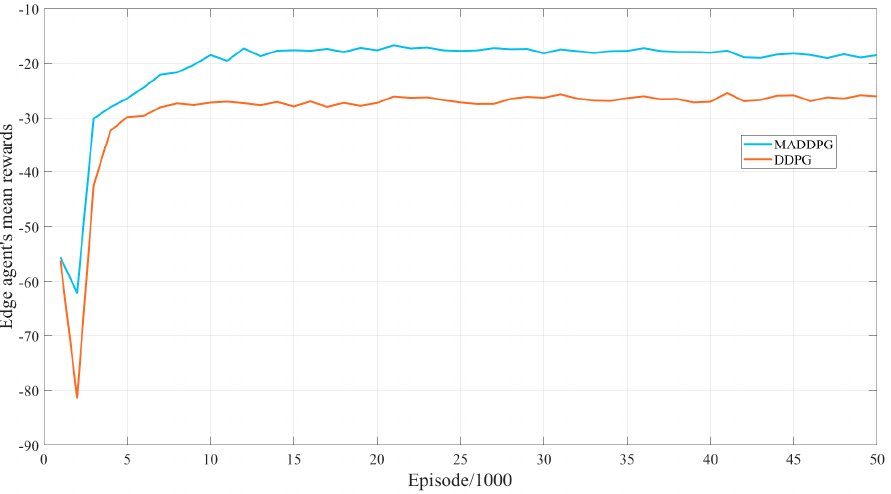
Figure 5. Comparison of MADDPG-based and DDPG-based algorithm’s mean rewards for an edge agent.